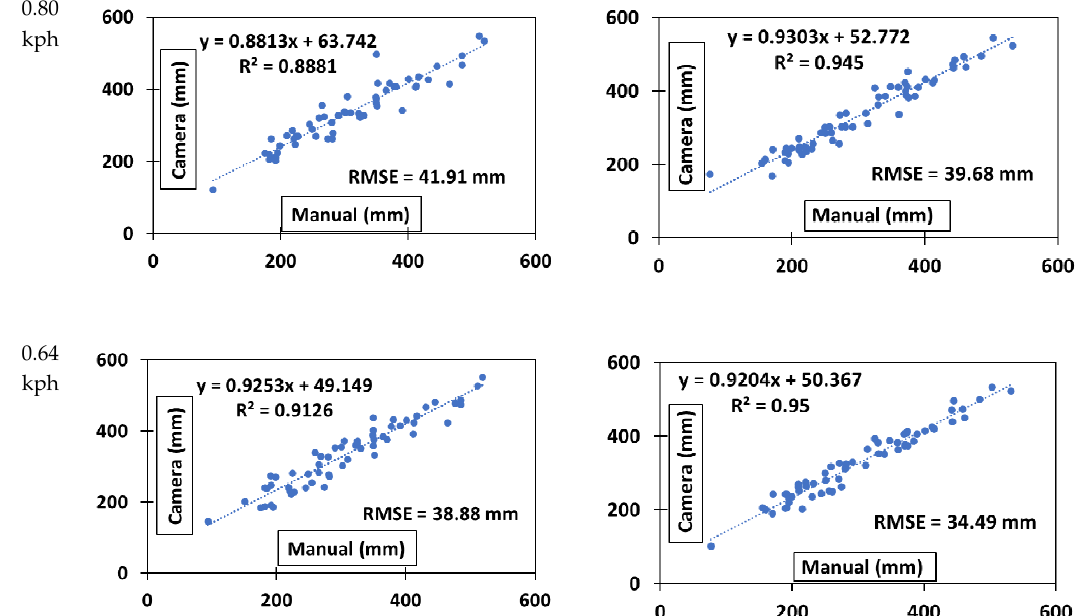
Figure 14. Comparison of 15 pixels contour and 5 pixels contour for 1.04 kph (fast speed), 0.80 kph (slow speed), and 0.64 kph (very slow speed) of cotton boll position measurements.